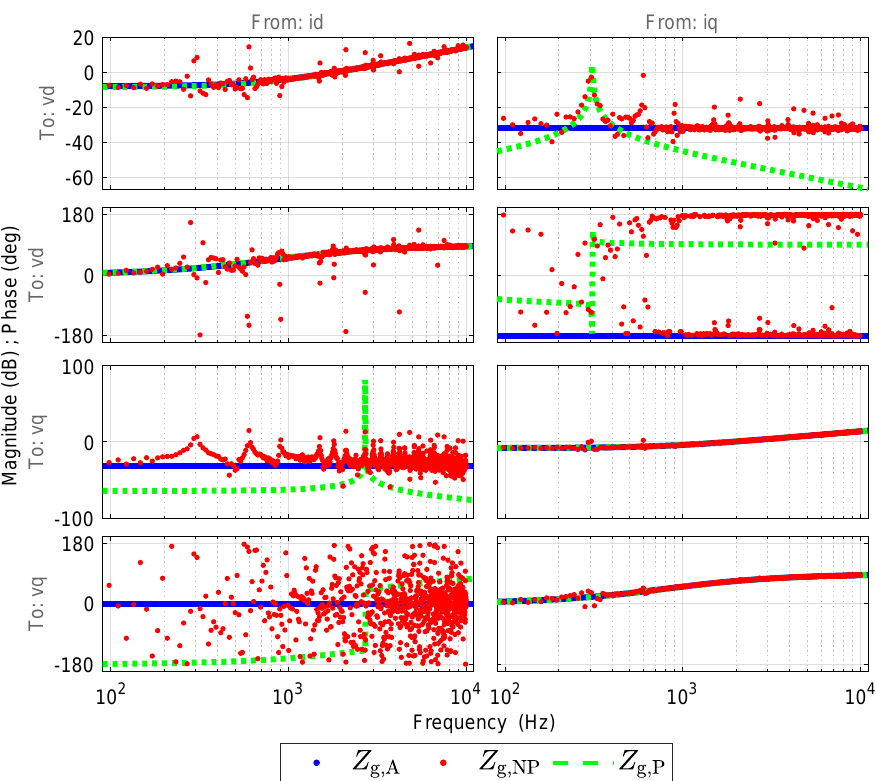
Figure 17. Identification of the parametric impedance based on non-compensated measurements.